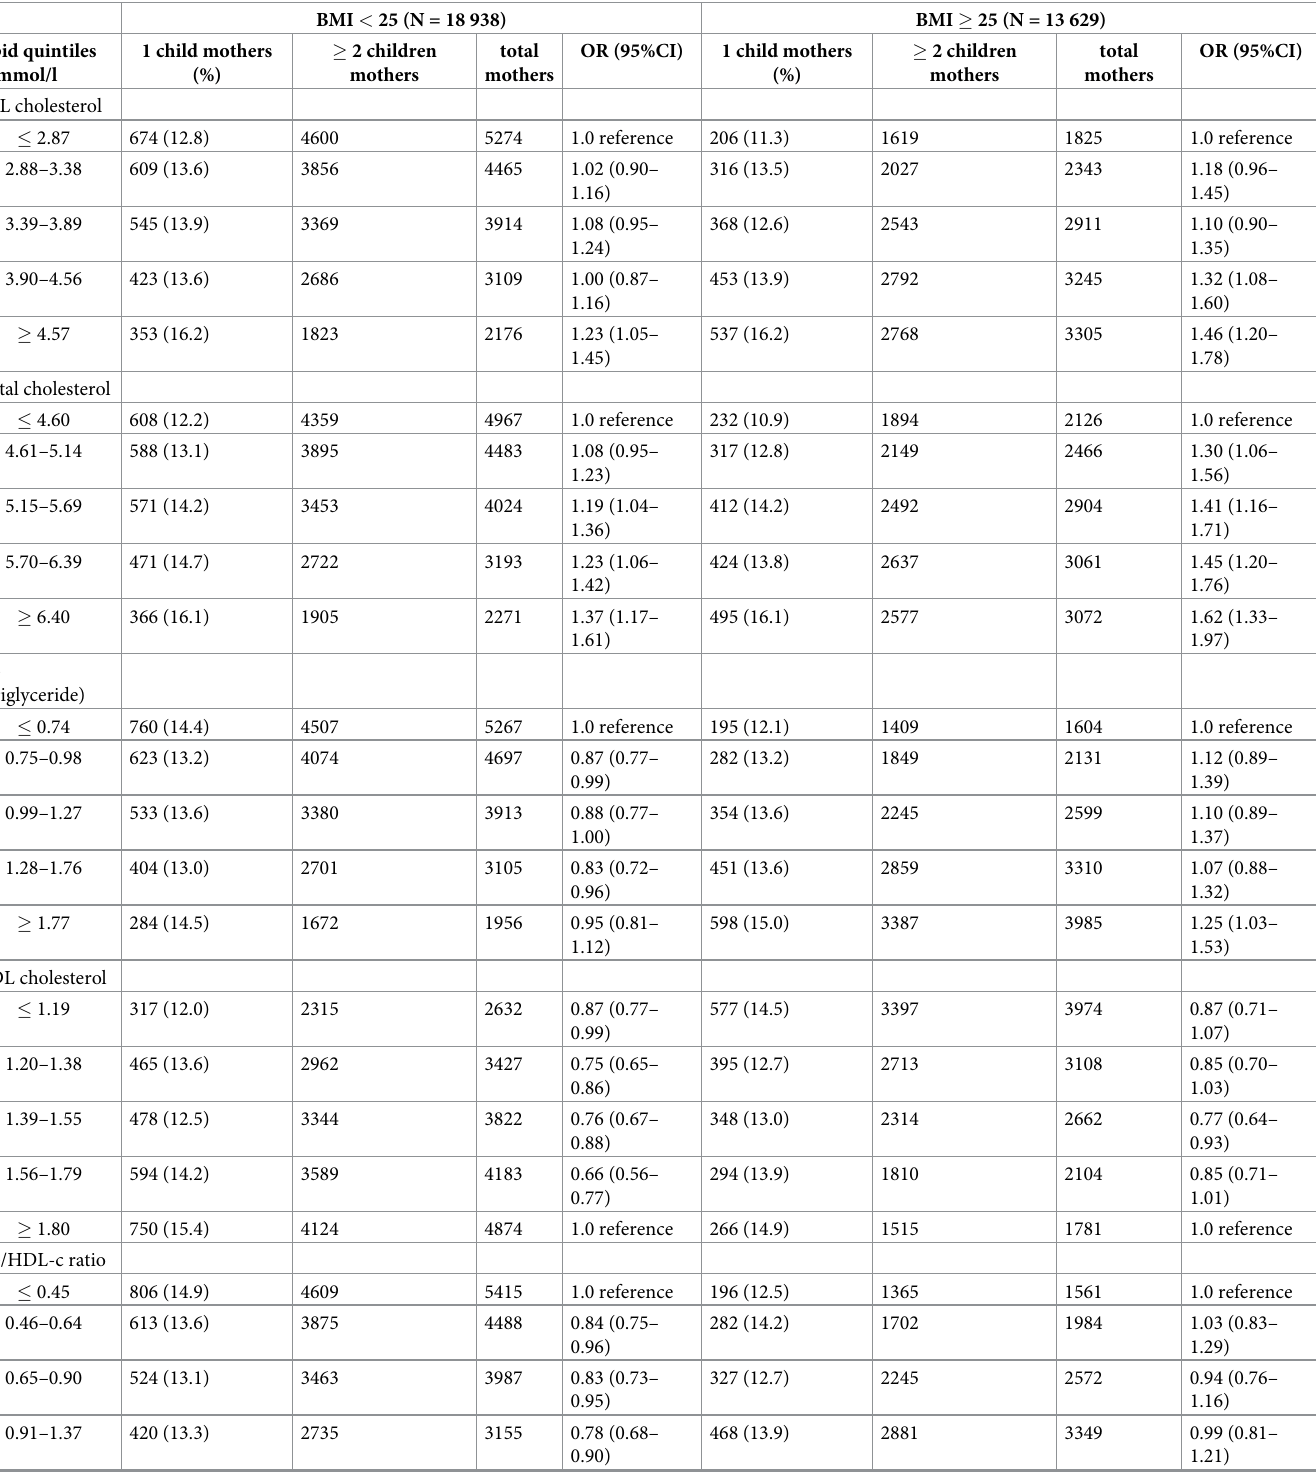
Table 2. Adjusted odds ratio (OR) with 95% confidence interval (CI) for one lifetime pregnancy by lipid quintiles stratified by BMI (kg/m 2 ), Cohort of Norway, 1994–2003, Estimates were obtained by logistic regression and adjusted for age at examination, year of first birth, oral contraceptive use, smoking, educational level and time since last